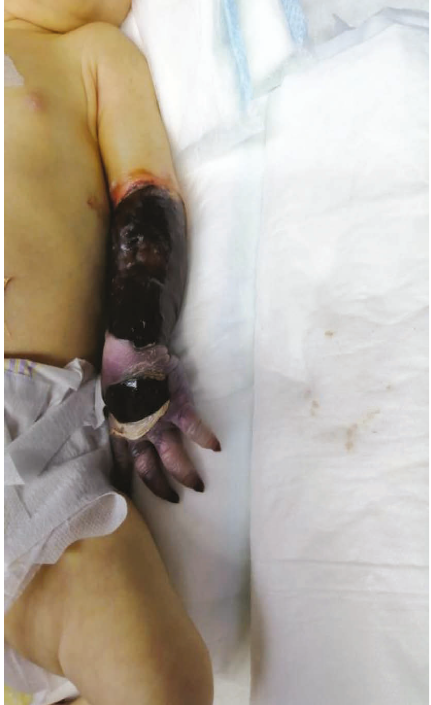
Figure 3: A photograph that shows left forearm and hand gangrene in our patient after the failure of medical